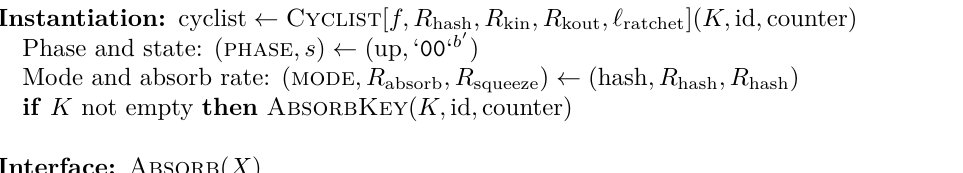
Algorithm 1 Definition of Cyclist [ f, R hash , R kin , R kout , ‘ ratchet